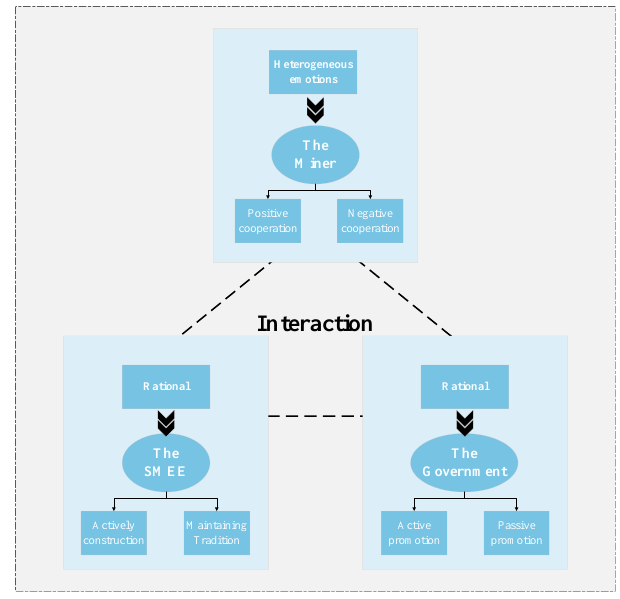
Figure 1. Conceptual diagram of the game model.